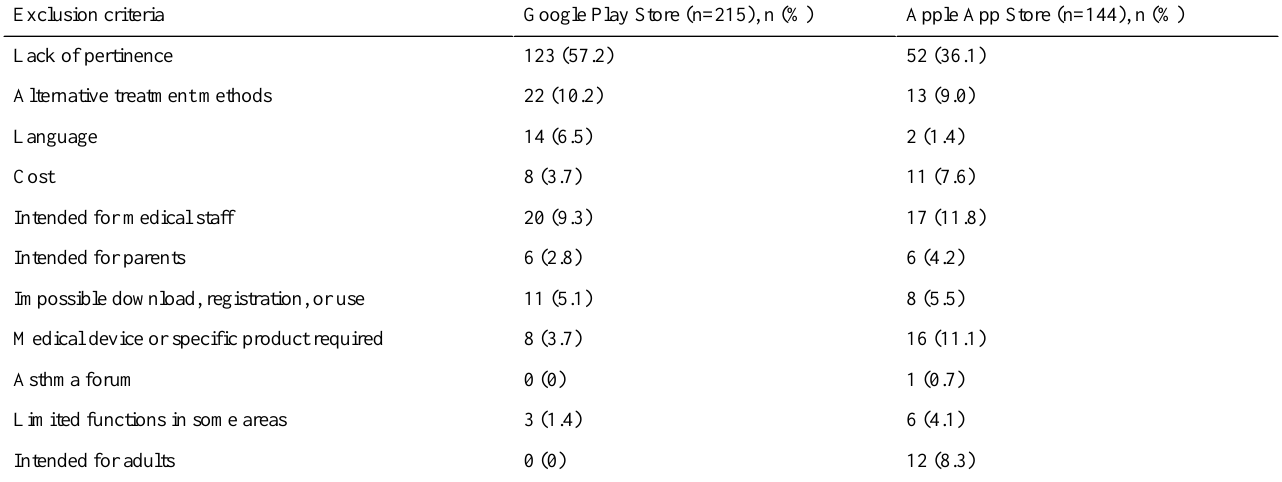
Table 1. Exclusion criteria for the asthma